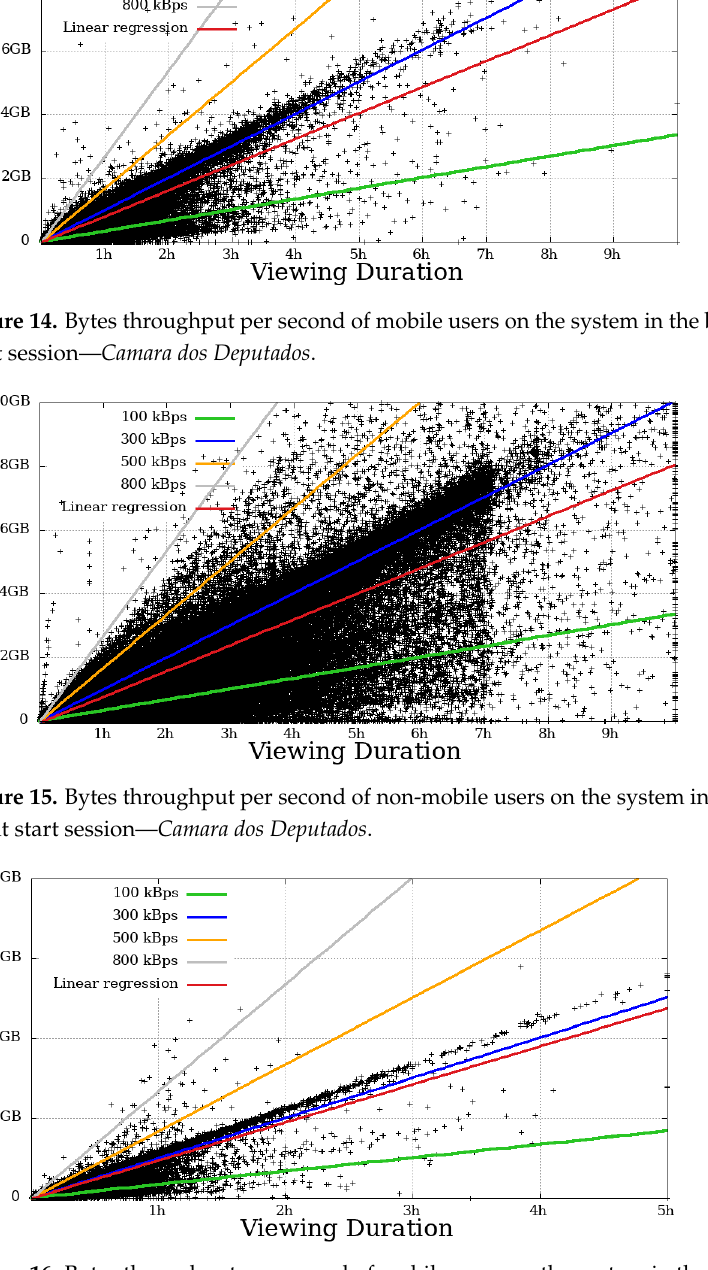
Figure 16. Bytes throughput per second of mobile users on the system in the broadcast Opening Rio 2016 Olympic